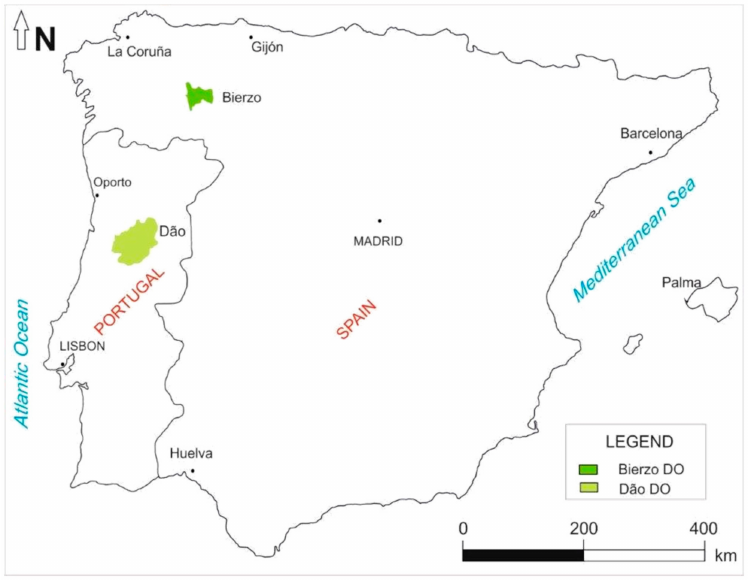
Figure 1. Location of Bierzo D.O. and D ã o D.O. where ‘Menc í a’ and ‘Jaen’ monovarietal wines are